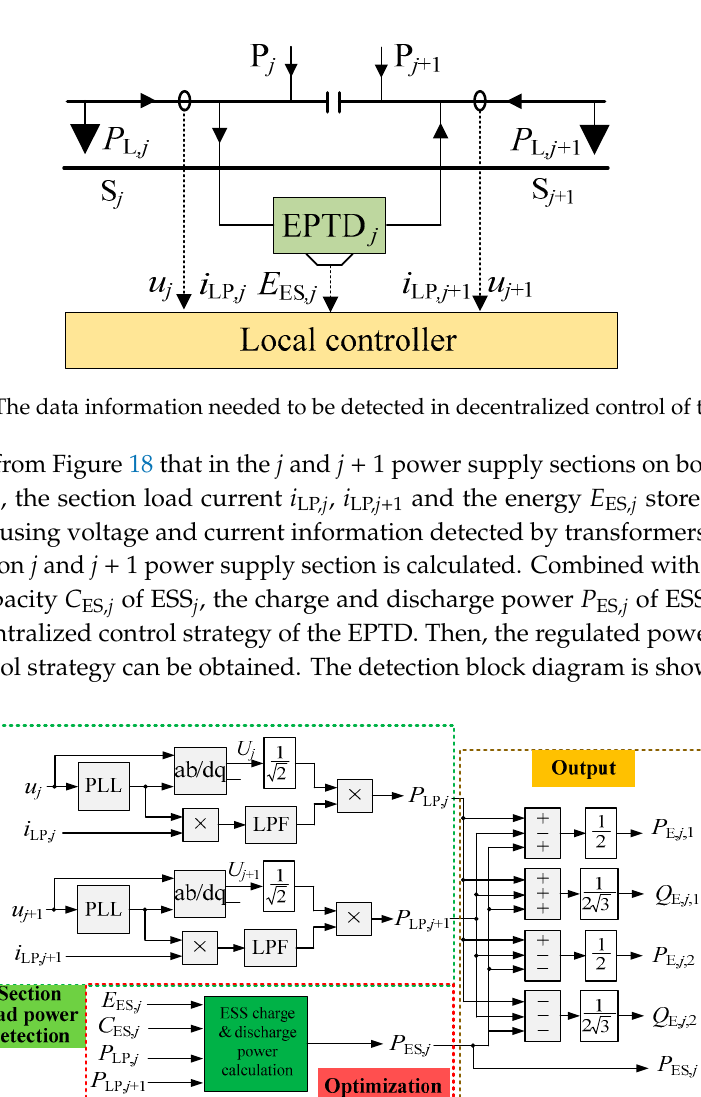
19 of 32 Figure 17. Detection block diagram in decentralized control of PTD. (b) Detection principle of EPTDs Since EPTDs can automatically deliver RBE from the section with RBE to the section with traction power when eliminating three-phase current imbalance. Therefore, EPTDs do not need to